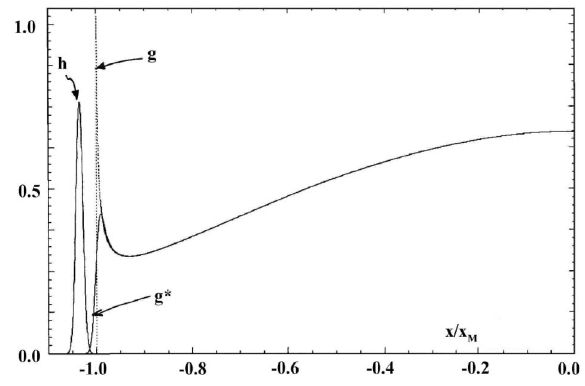
FIG. 4. Damping of the side peaks in g (cid:1) (cid:1) x (cid:2) (cid:1) g (cid:1) h (cid:1) x (cid:2) due to Gaussian momentum spread h (cid:1) d (cid:2) .